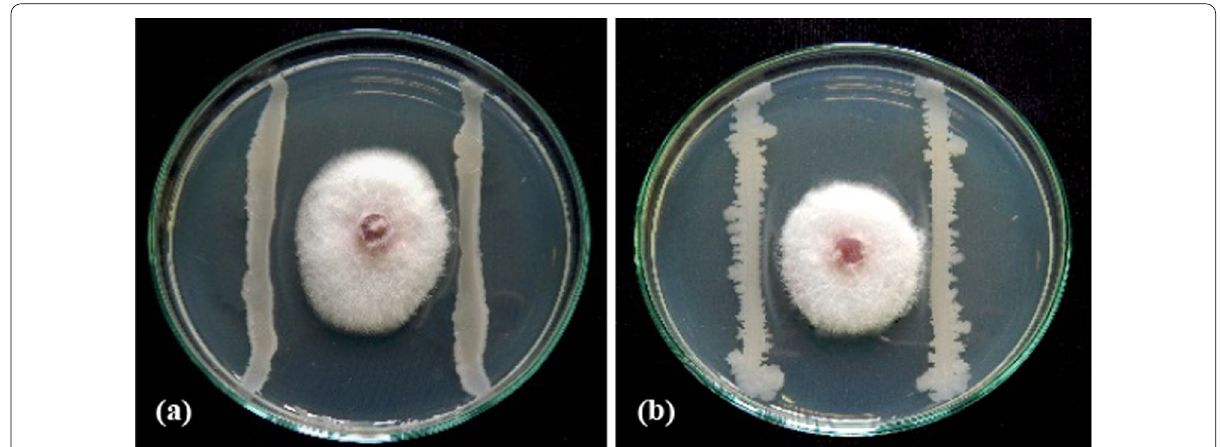
Fig. 1 Dual culture assay of Bacillus isolates against F. oxysporum f. sp . lycopersici: a ERBS10 and b ERBS51